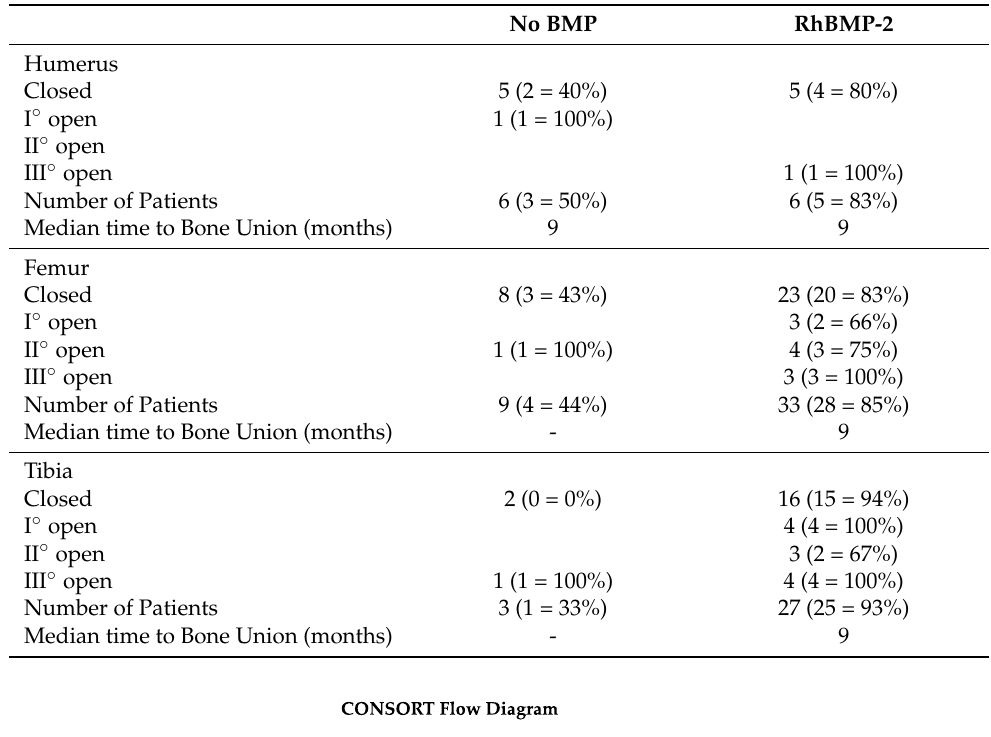
Table 1. Total number of non-unions (bone unions, union rate in %), and time to union for humerus, femur, and tibia, as well as degree of open fracture characterizing the study groups.